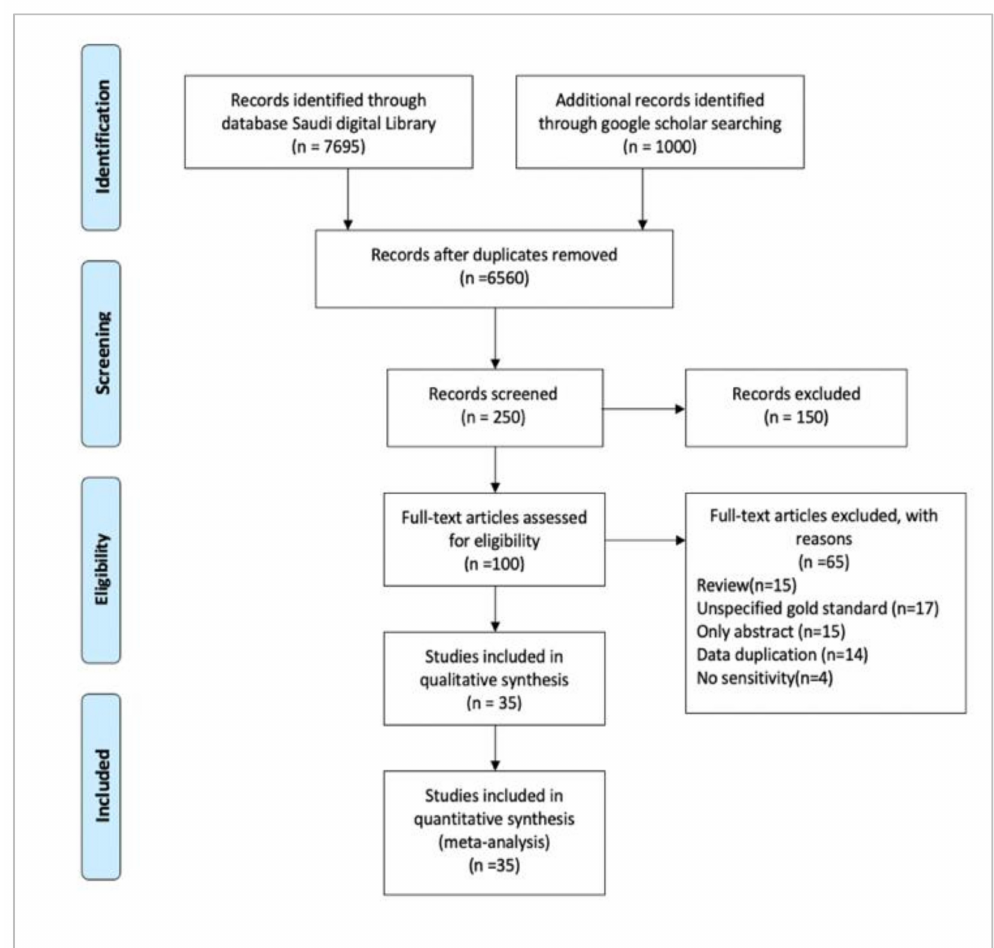
Figure 4. Schematic diagram PRISMA literature review.